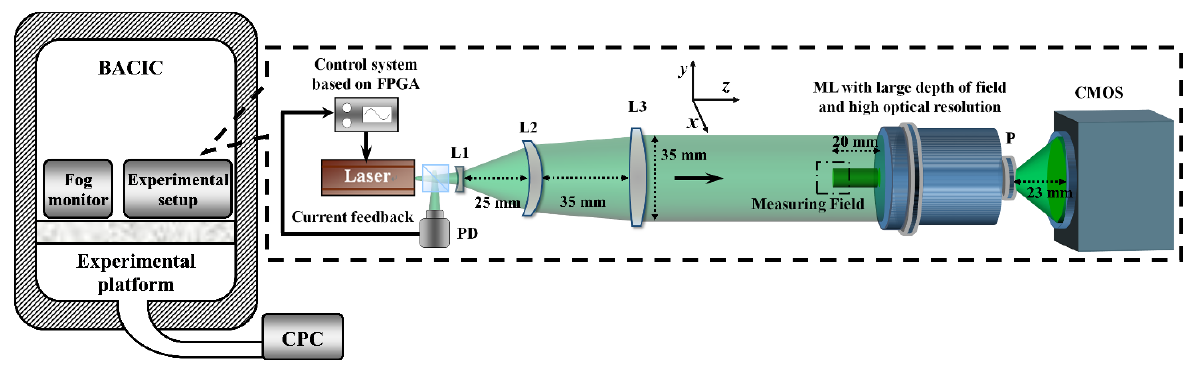
Figure 1. The measurement method of the DHI.